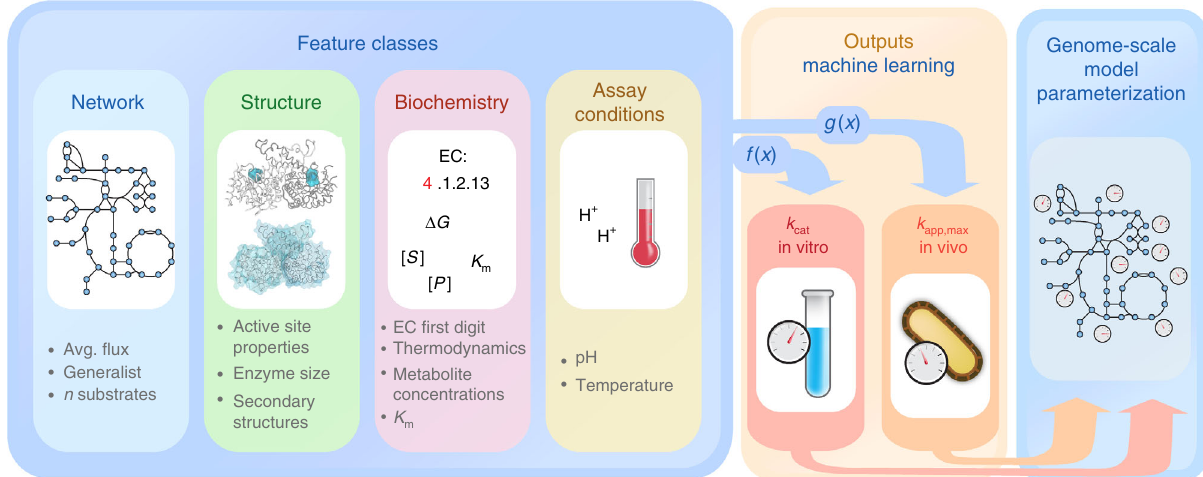
Fig. 1 Machine learning of catalytic turnover numbers for genome-scale metabolic model (GEM) parameterization. A feature set from diverse classes is curated and mapped to independently build machine learning (ML) models of both k cat in vitro ( f ( x )) and k app,max in vivo ( g ( x )). The inferred ML models are used to predict k cat in vitro or k app,max at the genome-scale to parameterize